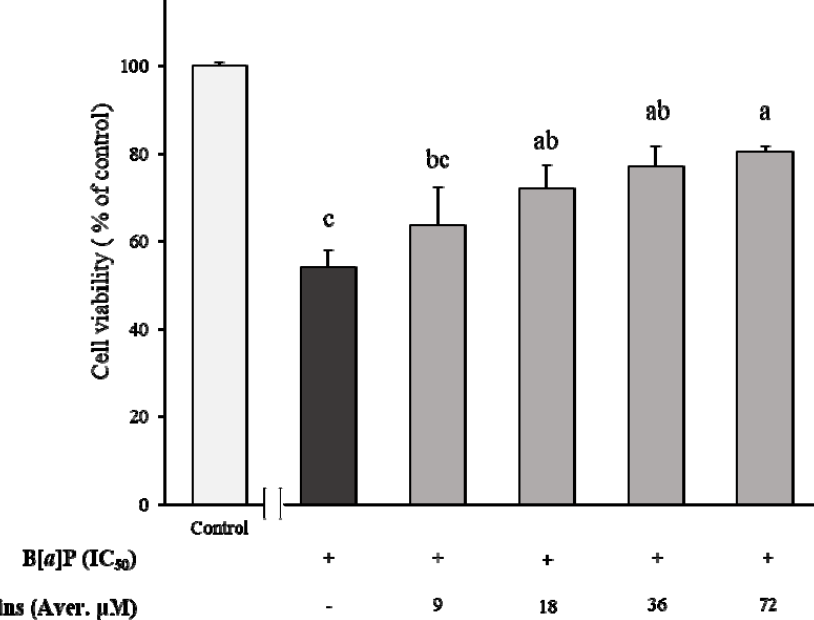
Figure 4. Determination of B[ α ]P treated HBMECs cell viability (% of control) after co-culture with di ff erent concentrations of catechins for 24 h. The values are mean ± SD in triplicate. Each bar with di ff erent letters is significantly di ff erent among treatments. a p < 0.01 as compared with control; b p < 0.01 as compared with control; c p < 0.001 as compared with control. Control indicates HBMECs treated by DMEM without B[ α ]P.